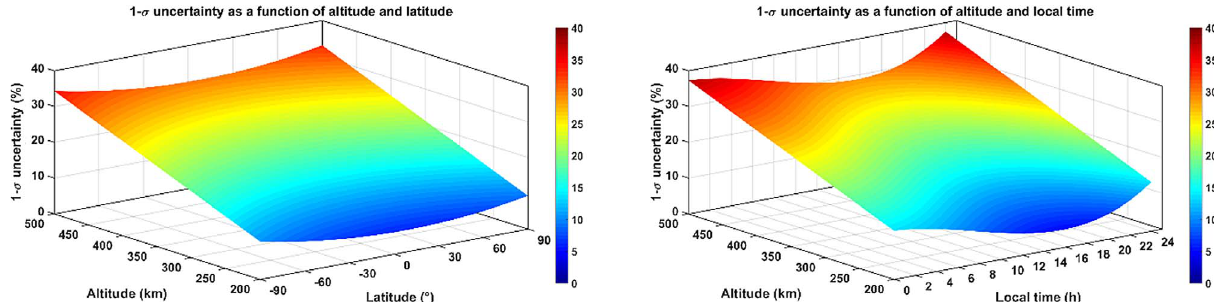
Fig. 6. 3D plot of the 1- r uncertainty (in percent) as a function of space variabilities: (left) altitude and latitude, (right) altitude, and local